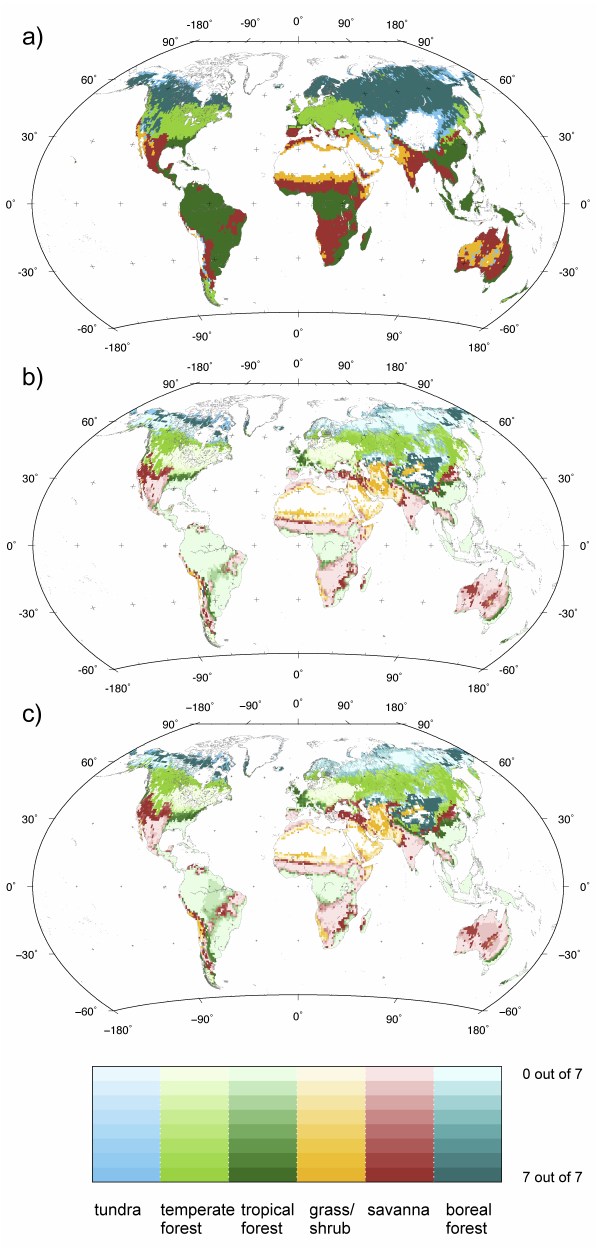
Fig. 3. Biomes derived from functional identities (FI) for present- day (a) , with biome descriptions identified from matching FI clus- ters and biomes according to their geographic correspondence. Biome shifts for B1 (b) and A2 (c) future climates. Only grid cells that are predicted to shift their biome membership under all seven JeDi future climate simulations are mapped in the color of their new biome. In grid cells where less than seven simulations indicate a biome shift, the color intensity indicates the number of simula- tions suggesting a biome shift, with the lowest (highest) intensity indicating one (all seven) model(s) predicting a biome